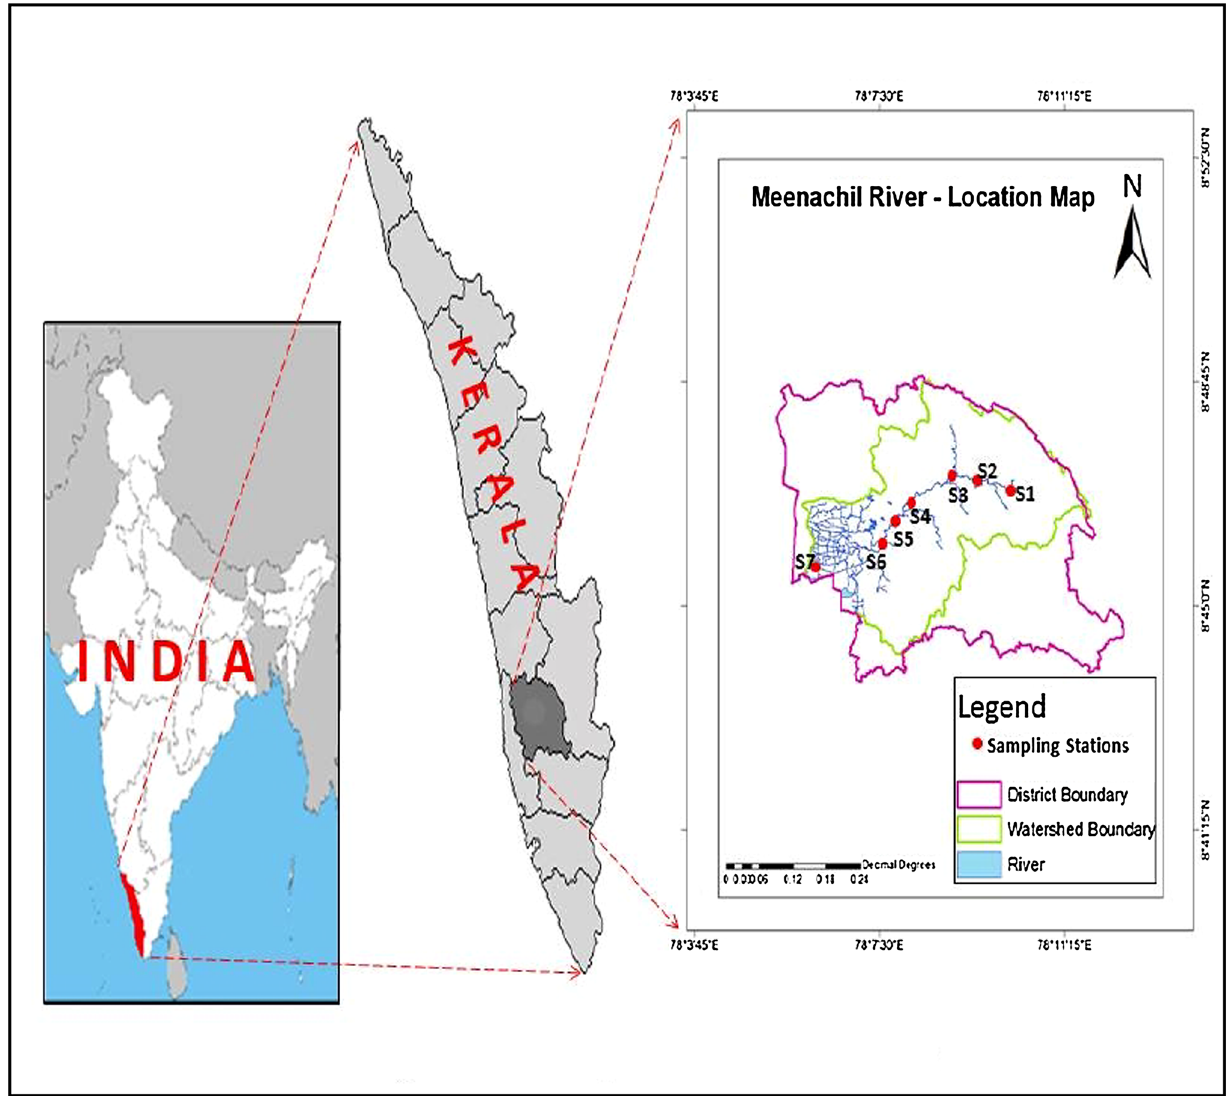
Fig. 1 Location map of Meenachil River